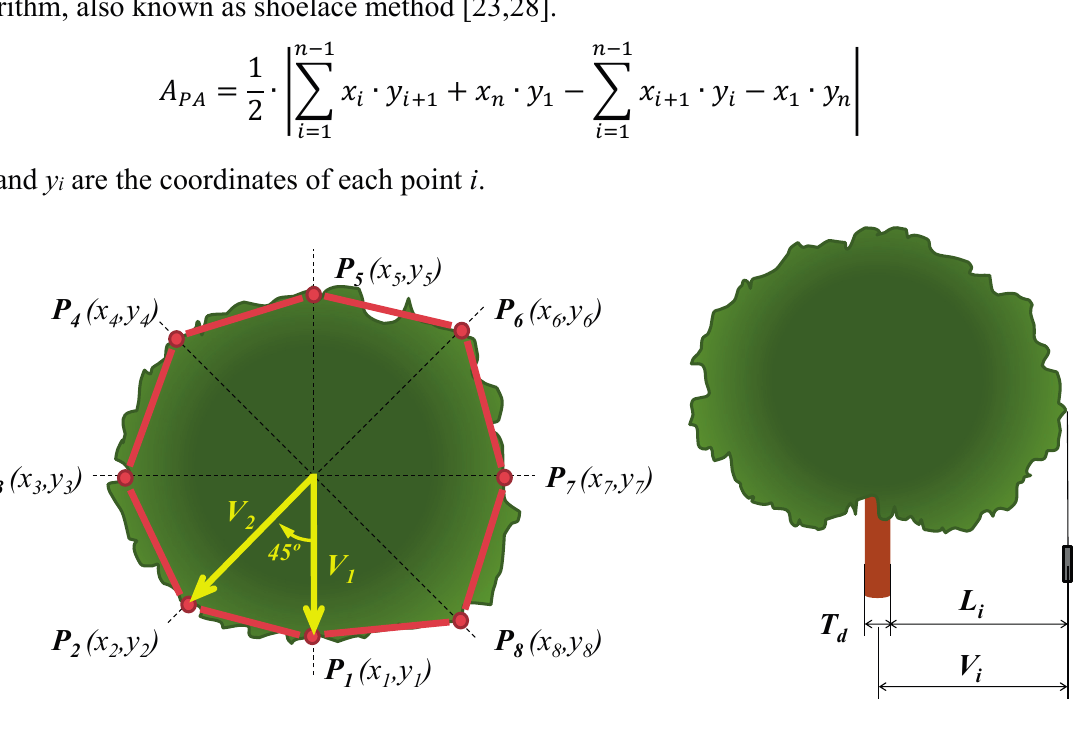
Figure 2. Vertical Tree Crown Projection’s Mean Vector measurement method ( left ) and Tree crown projection measurement method ( right